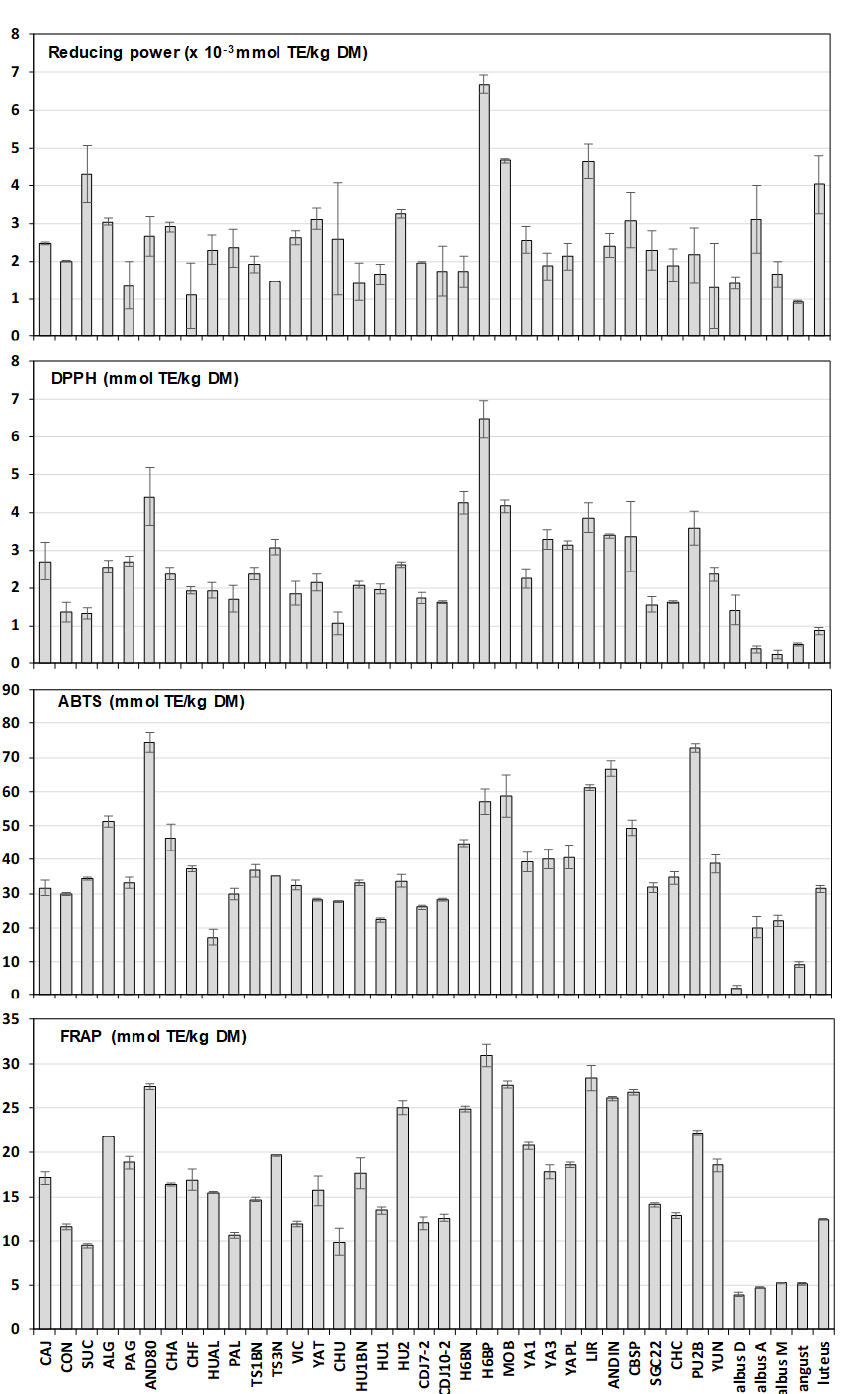
Figure 2. Antioxidant capacity (reducing power, DPPH, ABTS and FRAP methods) of debittered seeds of 33 L. mutabilis , three L. albus , one L. angustifolius and one L. luteus . The ecotype codes are defined in Supplementary Table S1. Error bars represent standard deviation.